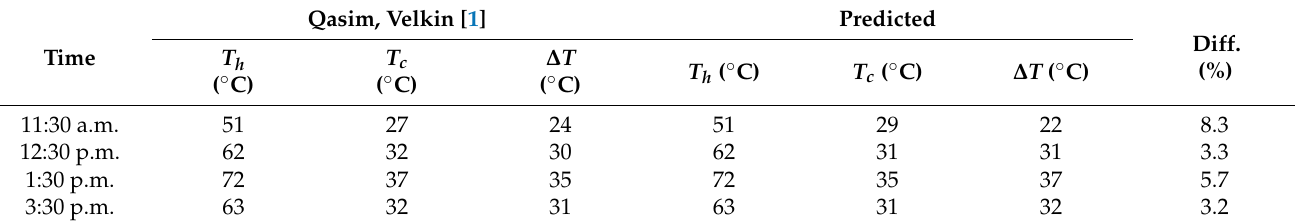
Table 4. Experimental data and model predictions obtained at different times of the day.